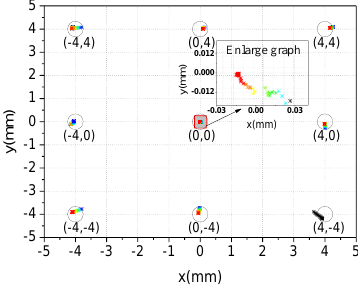
Figure 12. Calibration point coordinates with static voltage deduction.